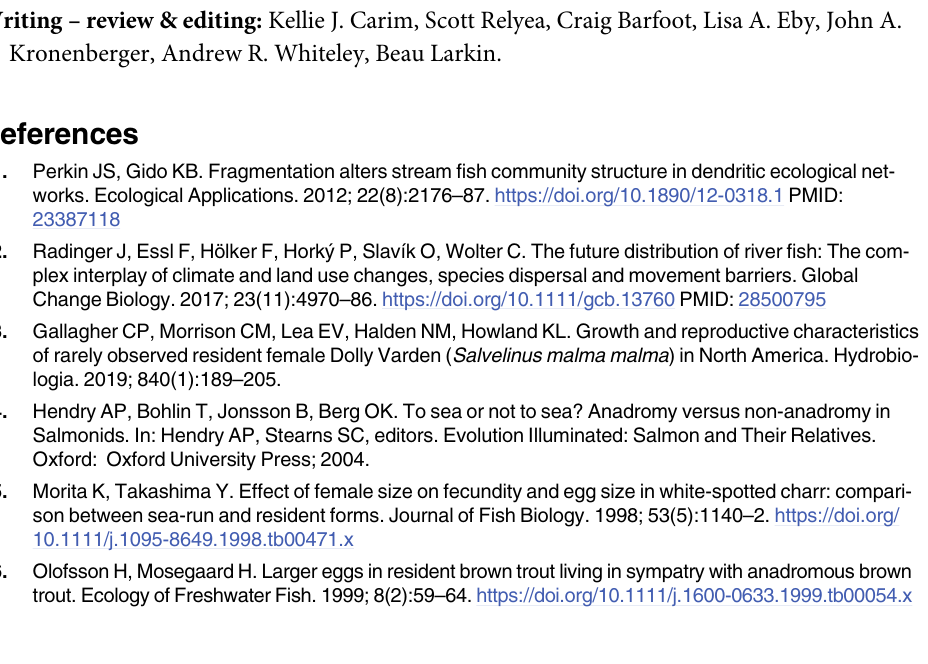
S1 Table. Consistency in maturity classifications of individual fish at Sekokini Springs Hatchery over repeated